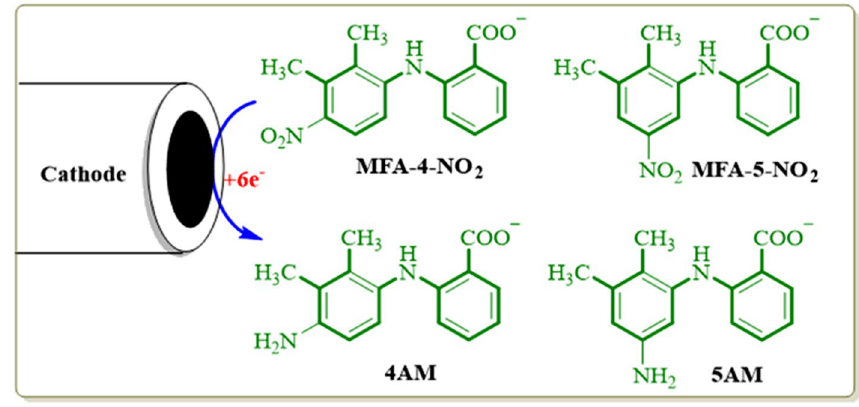
Figure 19. Reduction of nitromefenamic acid at the surface of glassy carbon electrode.